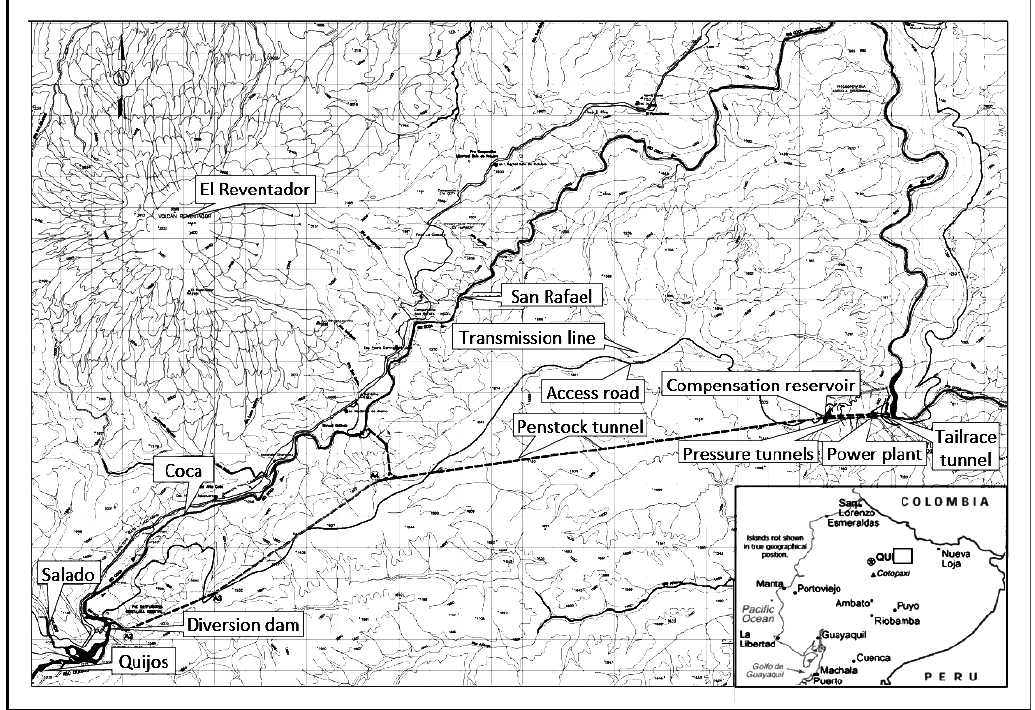
Figure 1. The Coca Codo Sinclair project and the surrounding area. Source: modified from [42].